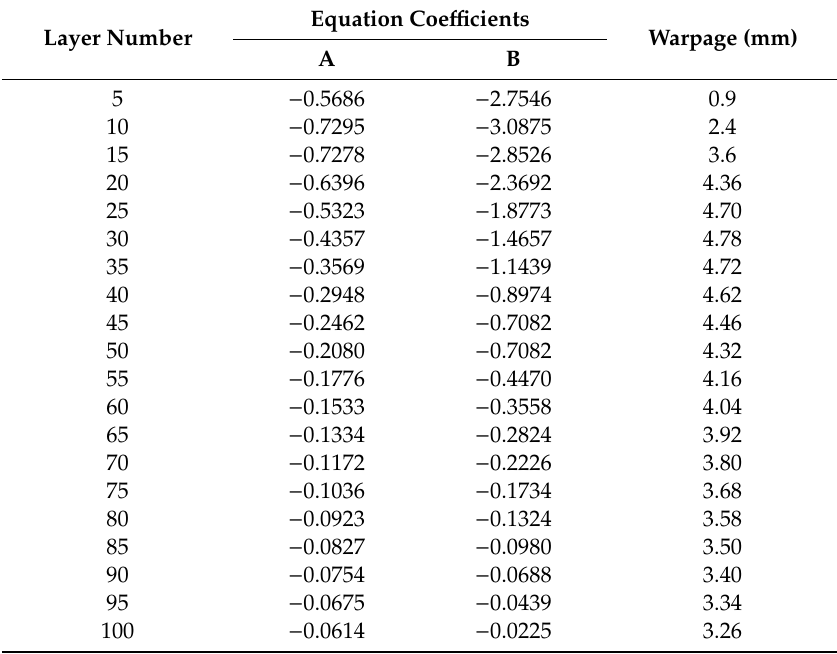
Table 1. Stress equation coefficients and warpage with different layers.